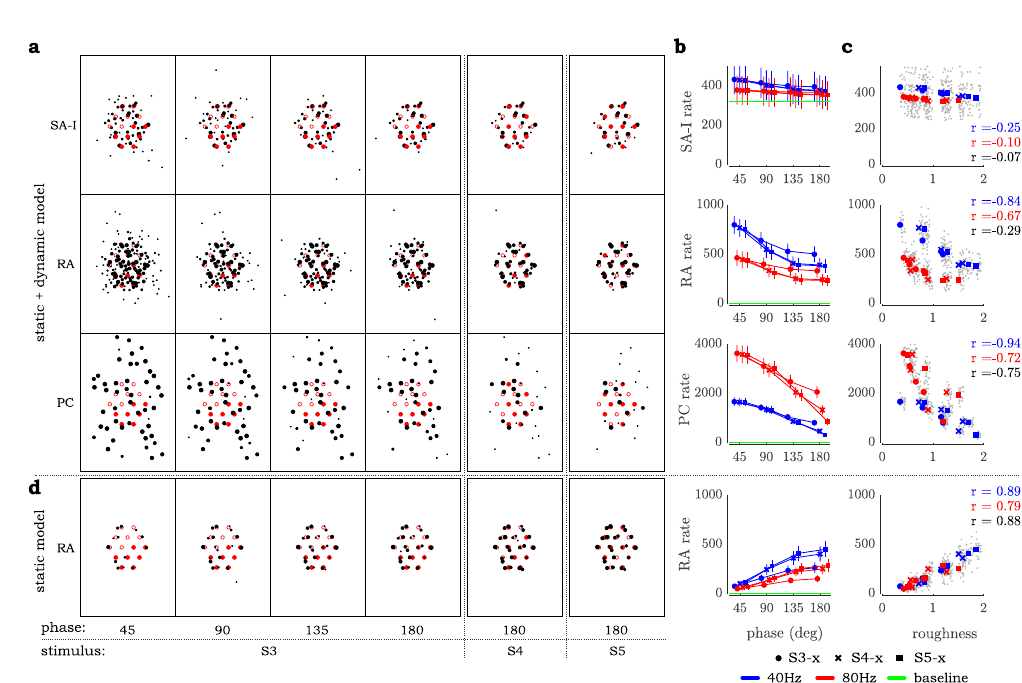
Figure 5. Results of TouchSim (TS) simulation with 1.2 mm base skin indentation and the same vibration amplitudes used in Experiment 3. ( a ) Spatial maps of afferent activity as measured by mean firing rate for each afferent (scaled black dots) relative to pin placement (red open and closed circles denote the two groups of pins) across a 10-s run. ( b ) Mean afferent firing rate, summed across the afferent population, plotted alongside base firing rates due to static pin indentation. ( c ) Firing rate as computed in ( b ) plotted against human roughness judgments from Experiment 3. Each grey point is the response of a single afferent over 20 10-s runs. Colored points are averaged across 20 runs, and r-values from correlations between rate and roughness across 20 simulations are coded by frequency (blue = 40 Hz, red = 80 Hz, black combined frequencies). ( d ) Spatial maps and mean RA firing rates generated by the TS simulation with only the static model component (dynamic wave propagation is disabled).